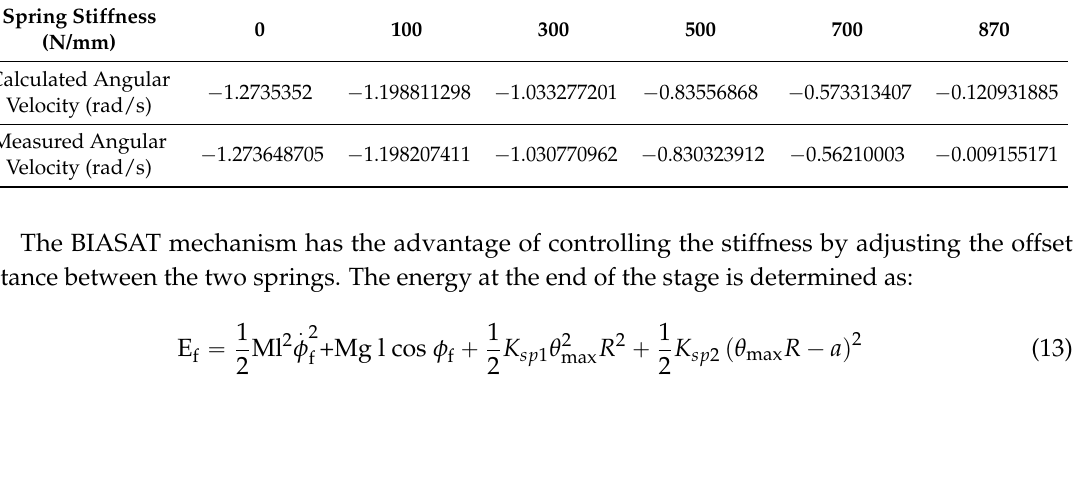
Figure 17. The angular velocity of the ankle joint in the support leg for different stiffness values. Table 1. Estimated and measured final angular velocity for different